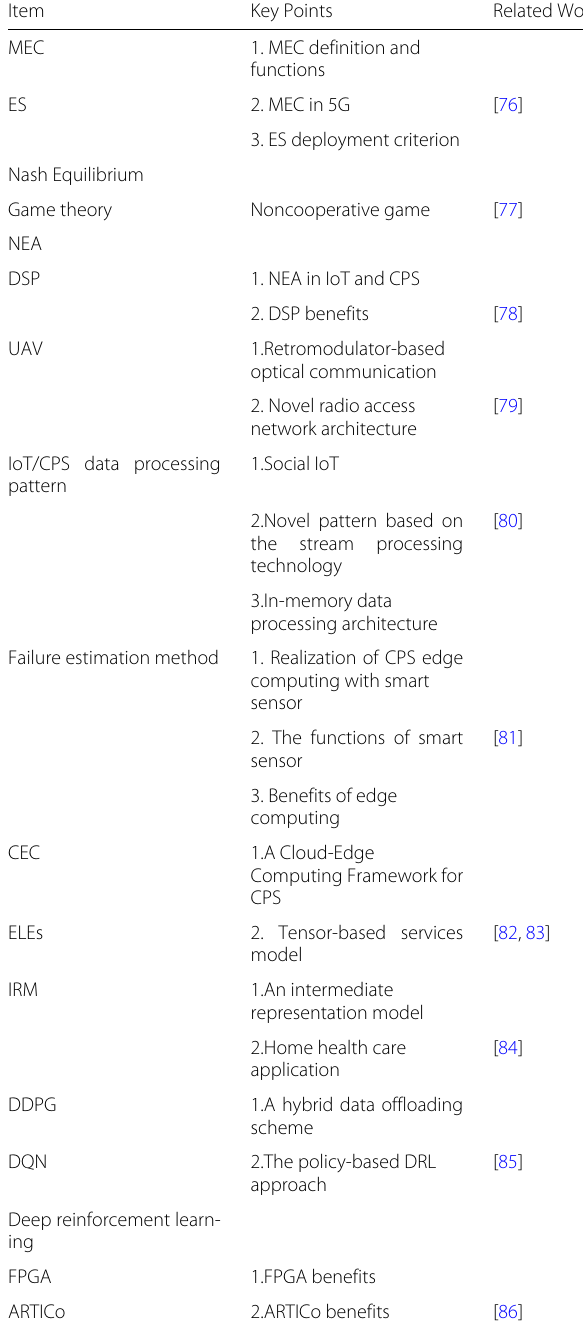
Table 5 Summary of literatures about methods on edge computing based